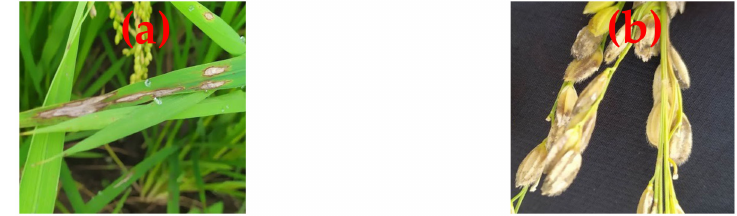
Figure 1. The symptom of rice blast in ( a ) leaf and ( b )